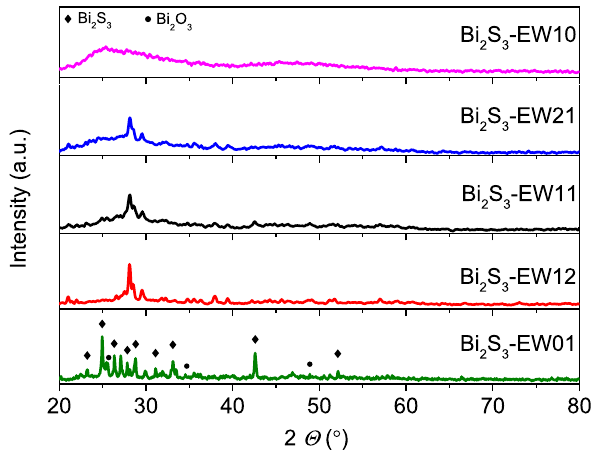
Fig. 2 XRD patterns of bismuth sulfides synthesized in the mixture of ethanol and distilled water with various volume ratio